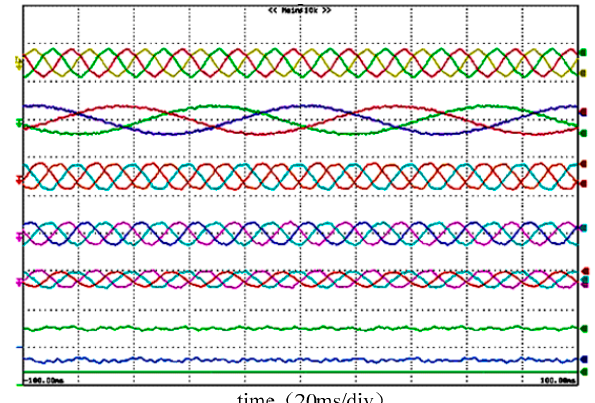
Figure 14. Experimental results of the MRSMC for a DFIG system.